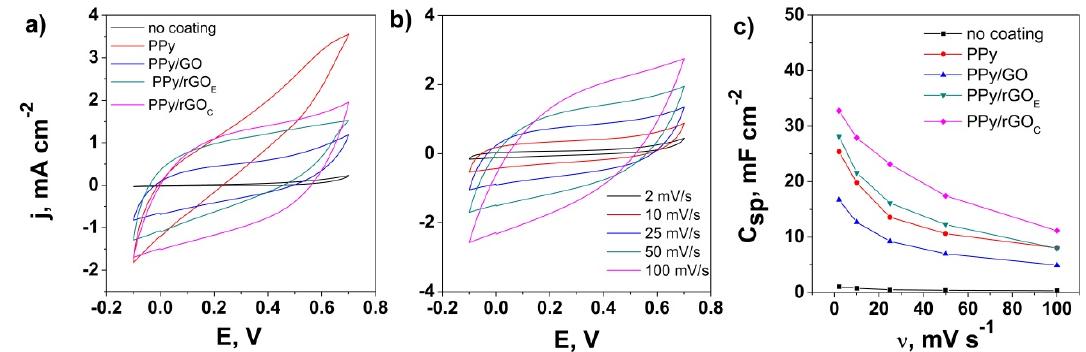
Figure 6. CV evolution of the PPy with coating on the CS substrate ( a ), cyclic voltammetry (CV) curves of the PPy/rGO C – CS with the scan rate ( b ), and the specific capacitance (C sp ) as a function of the scan rate ( c ).